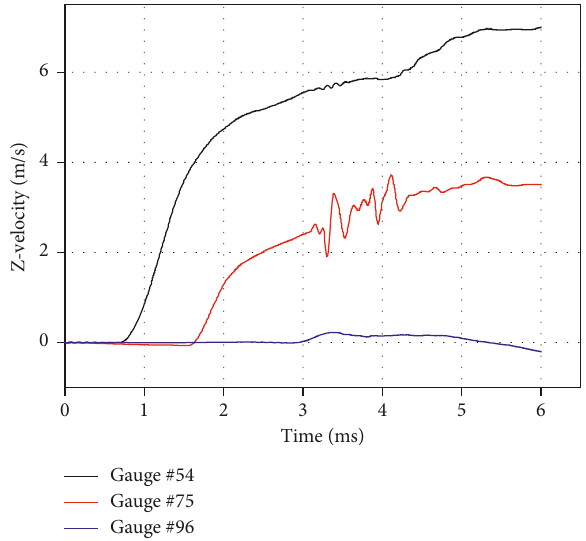
Figure 17: Velocity-time history of Gauges.